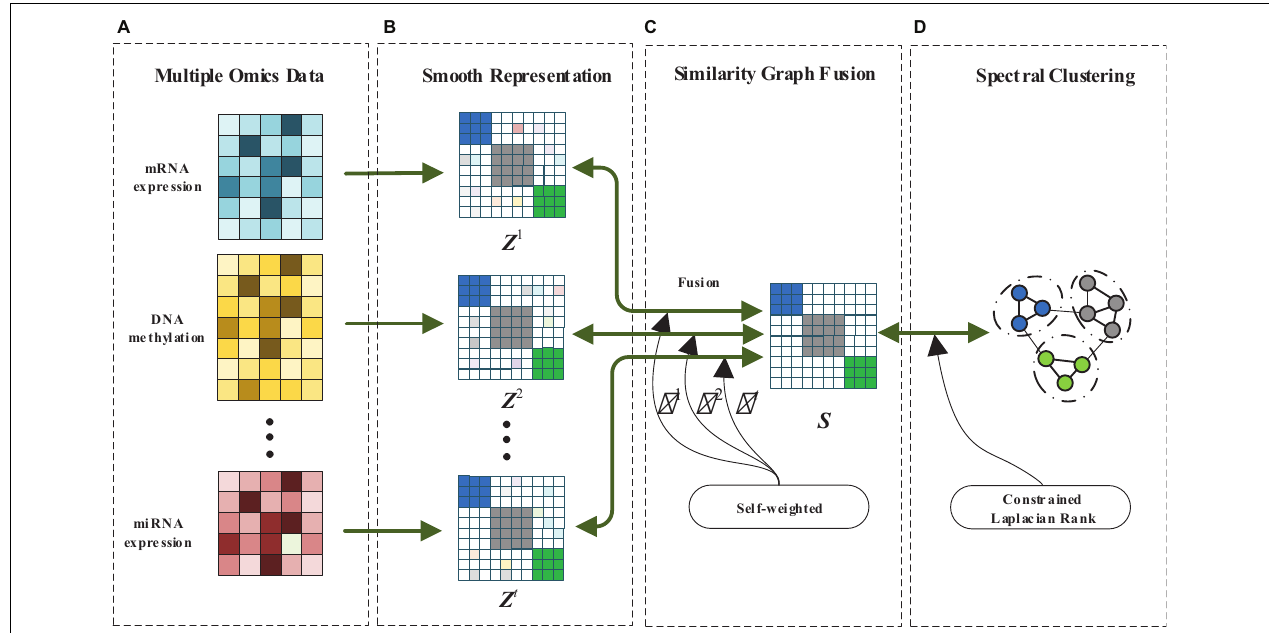
FIGURE 1 | The framework of MRF-MSC. (A) Multiple omics data. (B) Smooth representation. (C) Similarity graph fusion. (D) Spectral clustering.